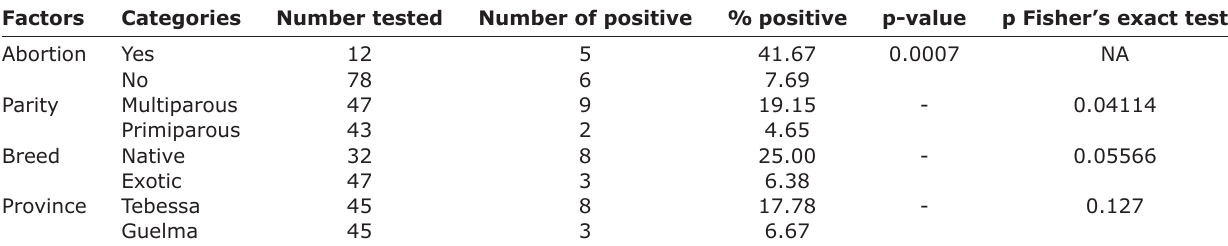
Table-2: Univariate analysis of the risk factors associated with the seroprevalence of sampled cows. Factors